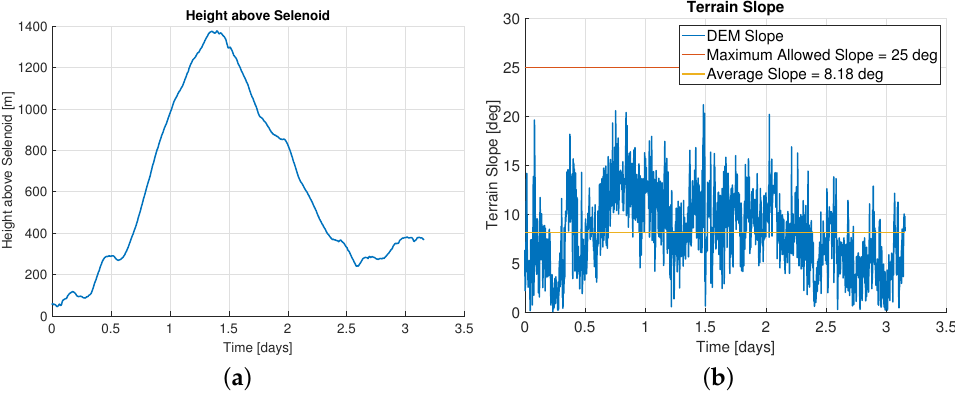
Figure 2. Rover altitude profile within the coverage of the high-resolution DEM. ( a ) shows the rover height above the Selenoid, while ( b ) shows the slope given by the